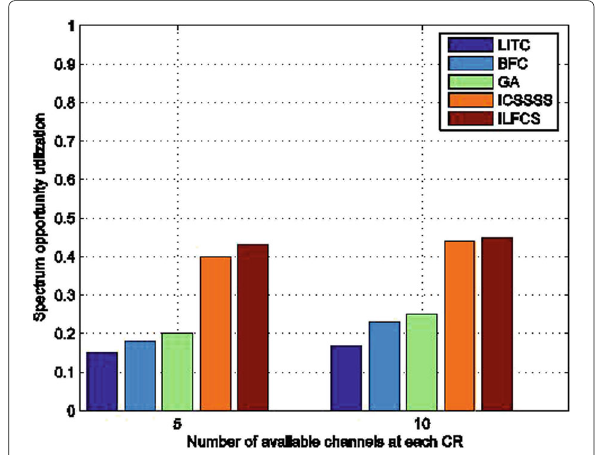
Fig.20 Spectrum opportunity utilization for LITC, BFC, GA, ICSSSS, and ILFCS in case of low PU activity level. The results of different simulation experiments to measure Spectrum opportunity utilization for LITC, BFC, GA, ICSSSS, and ILFCS in case of low PU activity level are shown